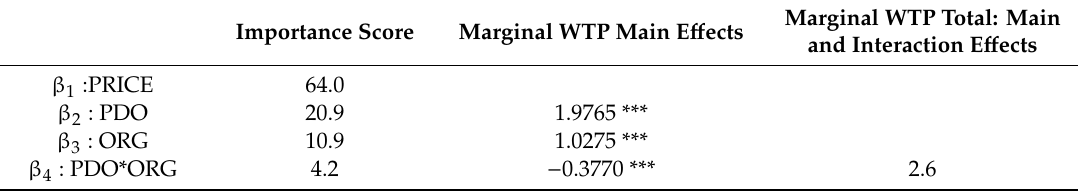
Table 4. Relative importance and marginal willingness to pay for the attributes (%, € /